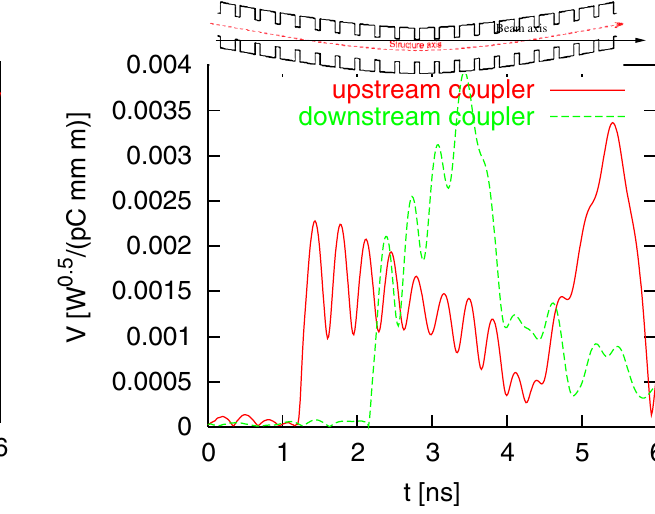
FIG. 11. (Color) Signal envelope upstream and downstream monitors vs time assuming structure axis tilted to beam axis.